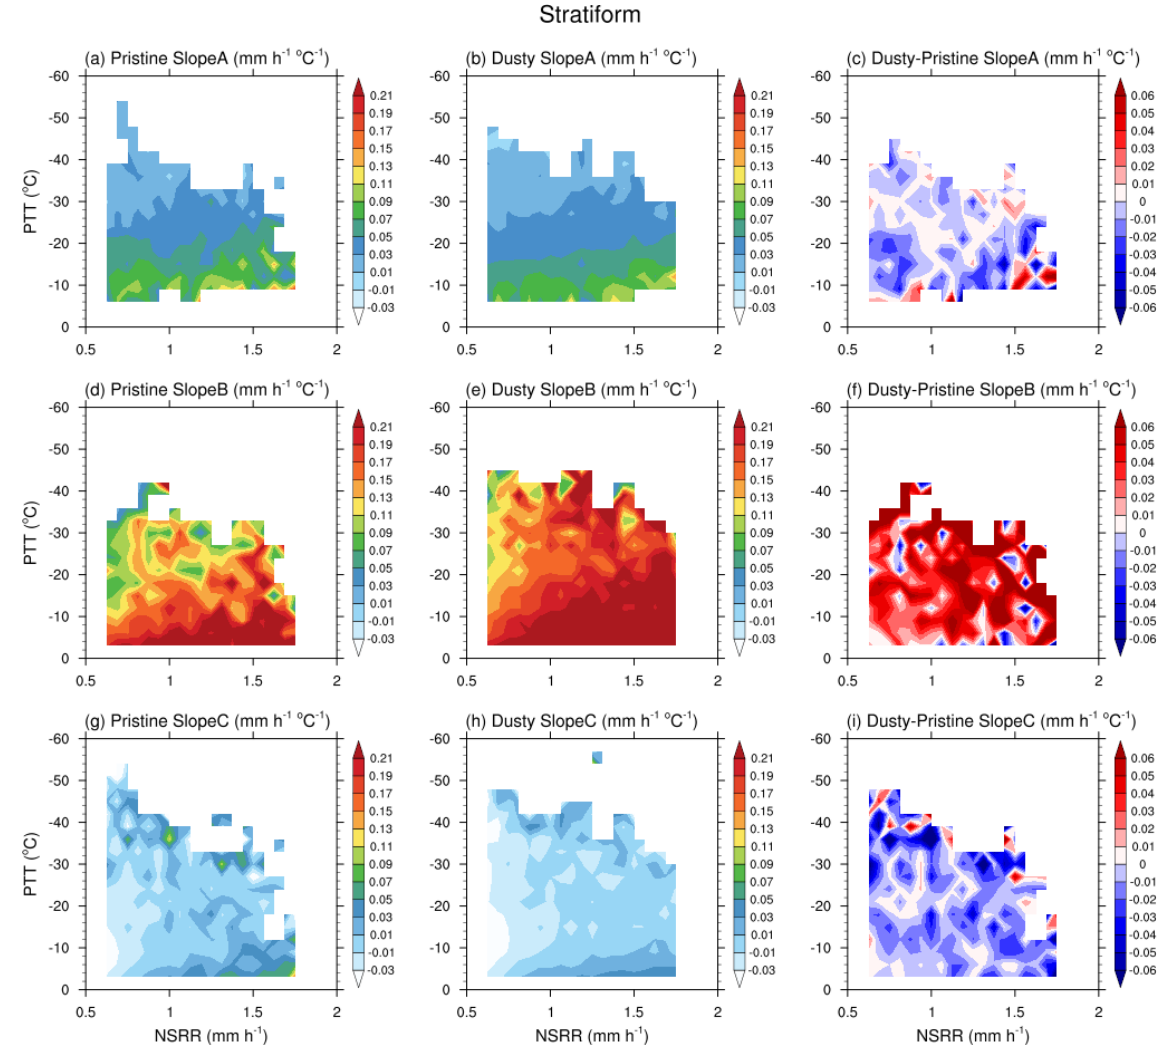
Figure 7. The mean SlopeA (a, b, c) , SlopeB (d, e, f) , and SlopeC (g, h, i) for stratiform precipitation as functions of the near-surface rain rate (NSRR) and precipitation top temperature (PTT) under pristine (a, d, g) and dusty (b, e, h) conditions; panels (c) , (f) , and (i) show the differences (dusty minus pristine) between the two conditions for each